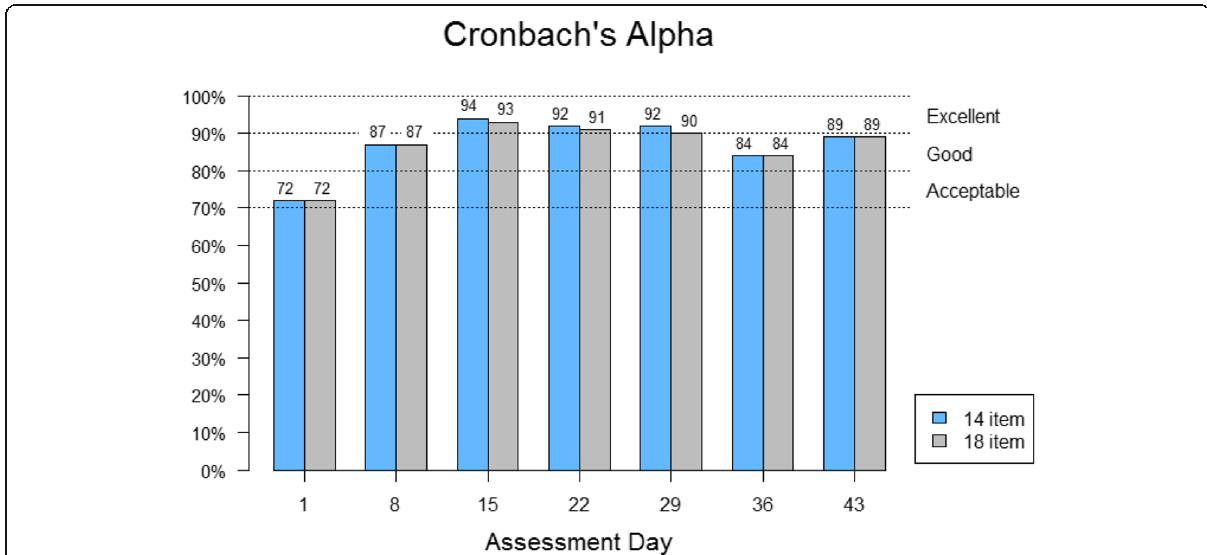
Fig. 4 Cronbach ’ s alpha. Cronbach ’ s alpha is a measure of internal consistency reliability. Reliability was assessed for the FACT-EGFRI 14 14-item score for the 14 skin toxicities and the full FACT-EGFRI 18 scale of 18 items. Coefficients of > 0.70 are considered sufficient evidence of